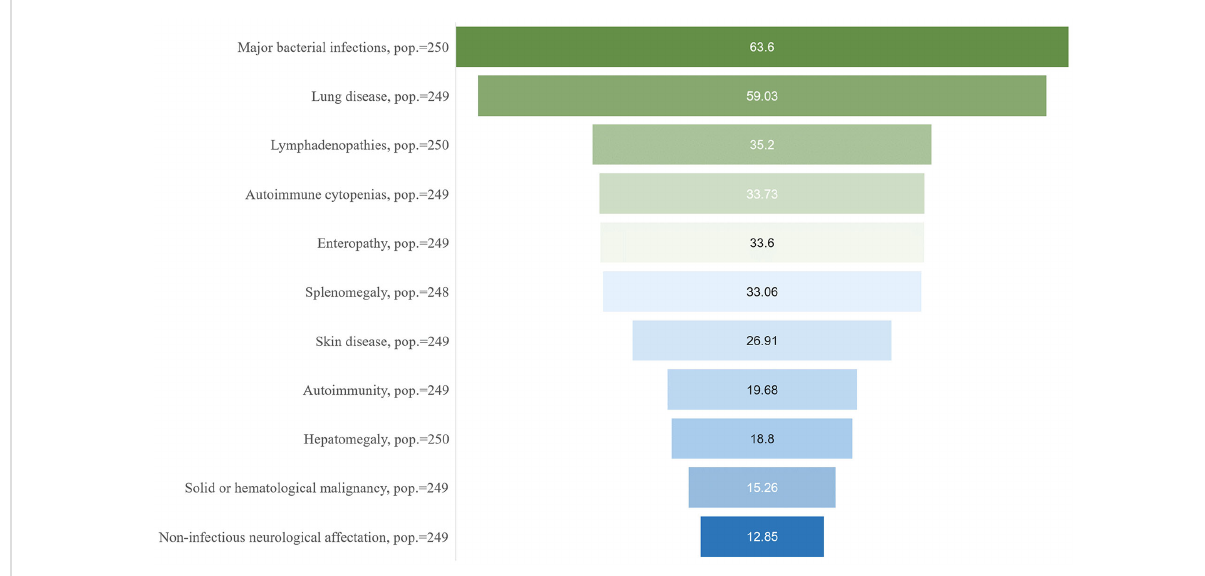
FIGURE 1 Summary of major comorbidities of the CVID patients included in the GTEM-SEMI-CVID Registry. Pop., number of patients for whom information on the speci fi ed variable was